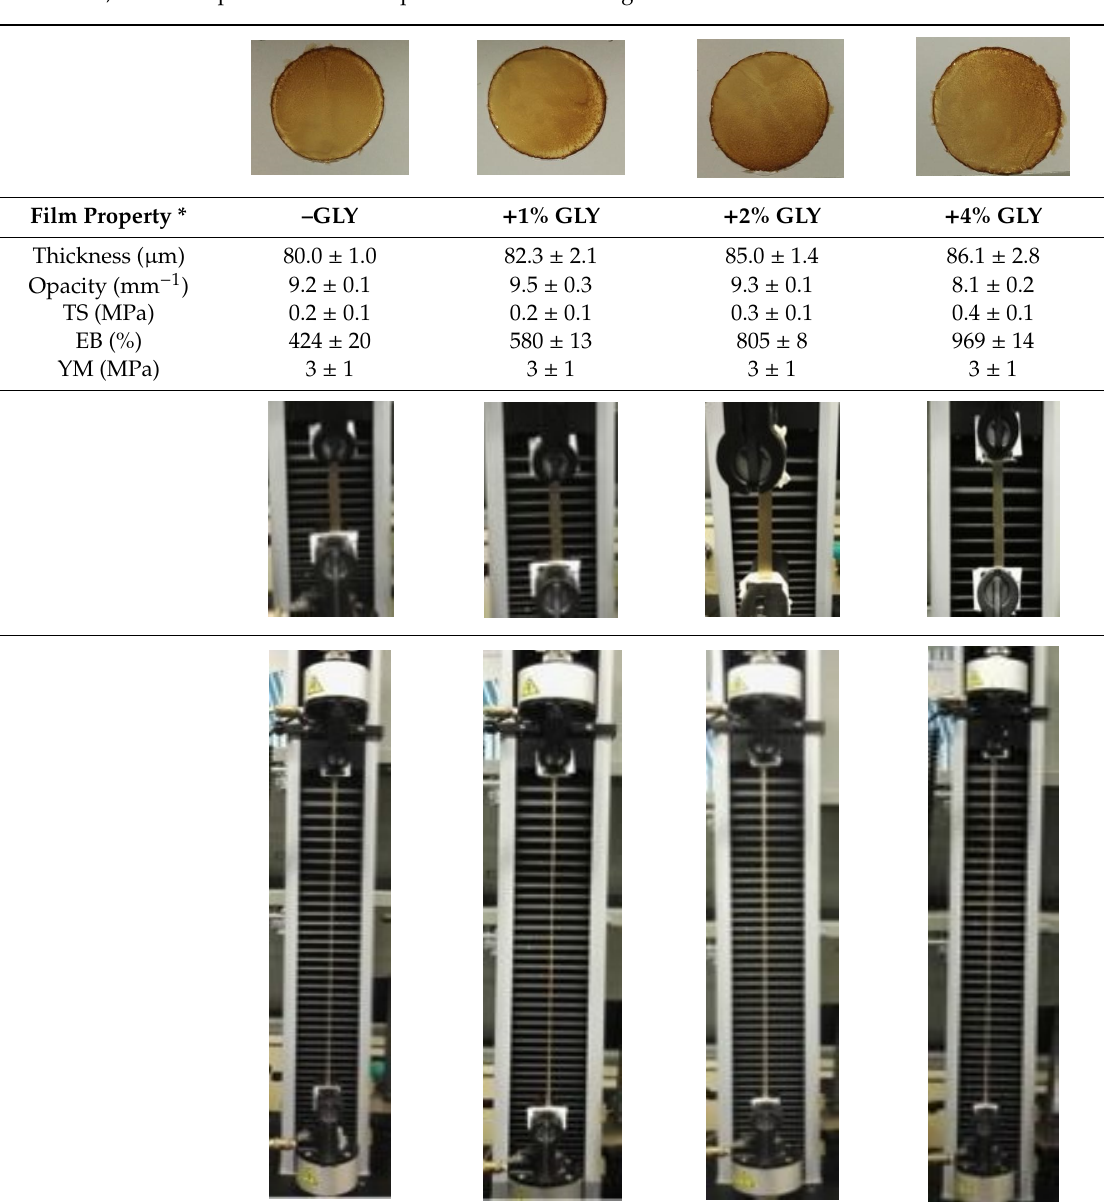
Table 2. Images and properties of the films obtained at pH 3.5 with 800 mg of dialyzed PGA preparation in the presence of different glycerol (GLY) concentrations. Images of tensile tests, before and after film stress, are also reported. Further experimental details are given in the text.